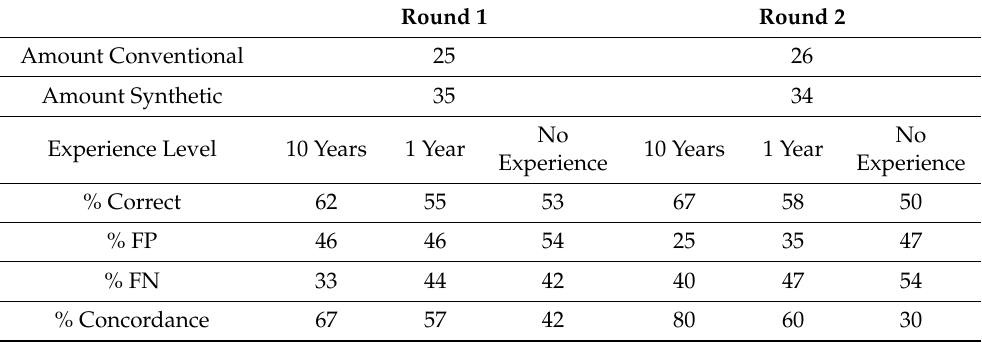
Table 1. The results from the first and second rounds of quality control tests. The second round used the deep learning segmentation pipeline and random sampling for the test creation. False positives are defined as conventional images that participants labeled as synthetic. False negatives are defined as synthetic images that participants labeled as conventional. Concordance between the participants is defined as the proportion of the same